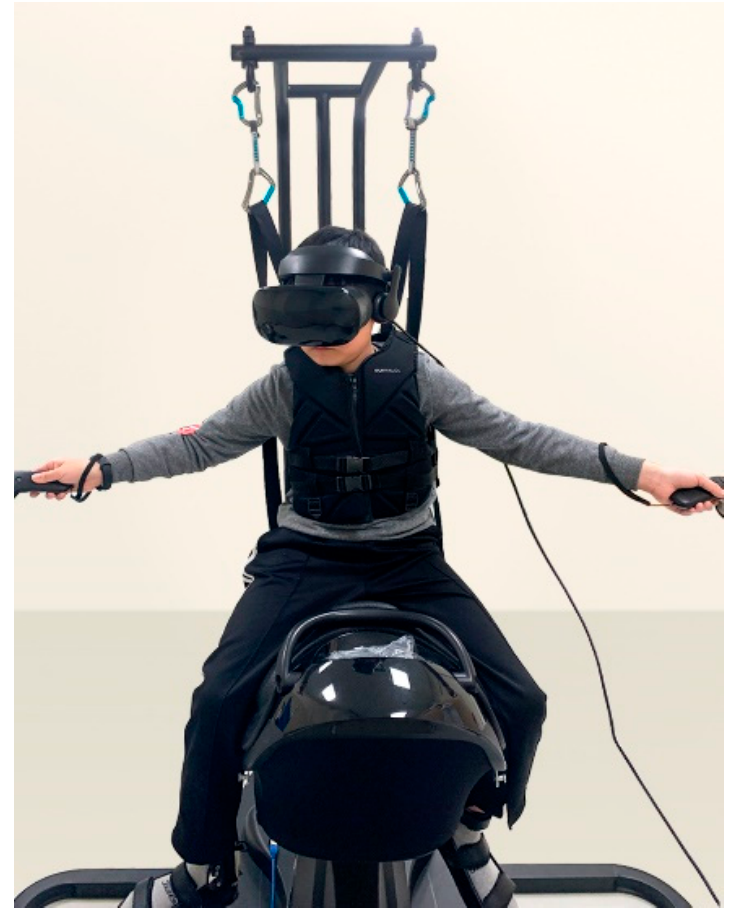
Figure 2. Children extend their hands to hit the target on the moving HRS.